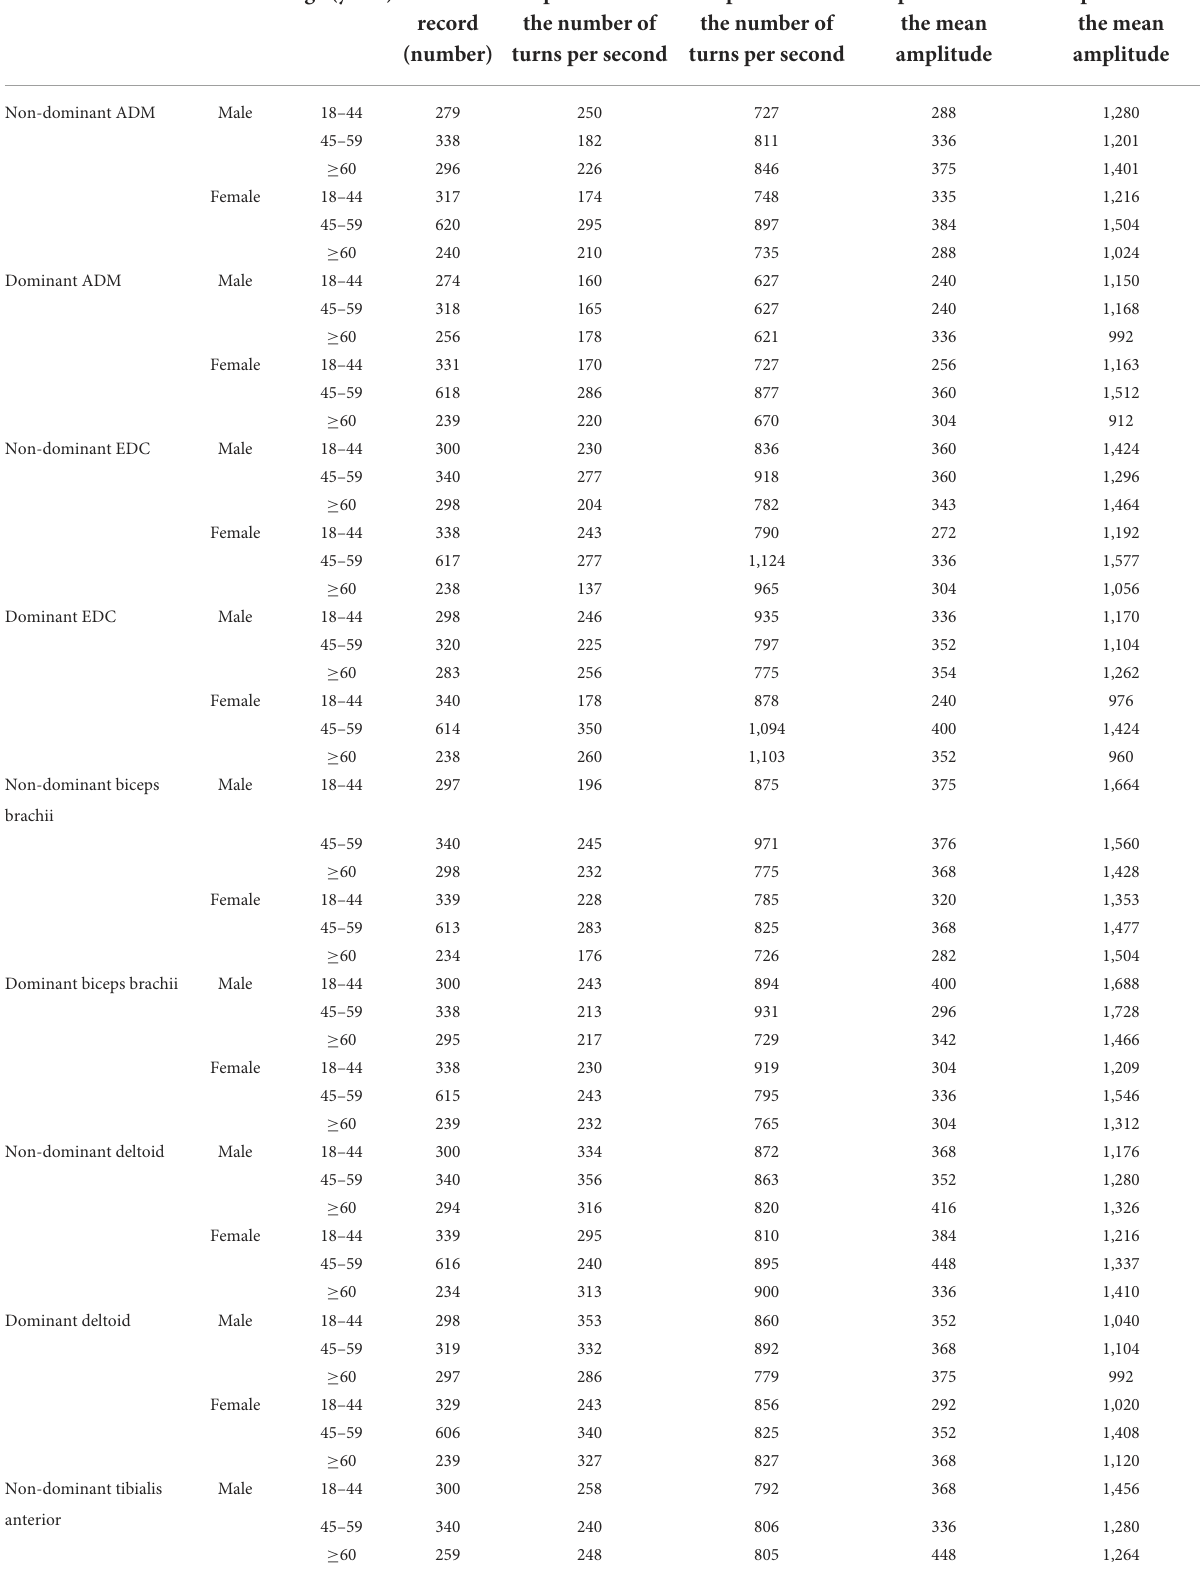
TABLE 8 The reference values of the percentile